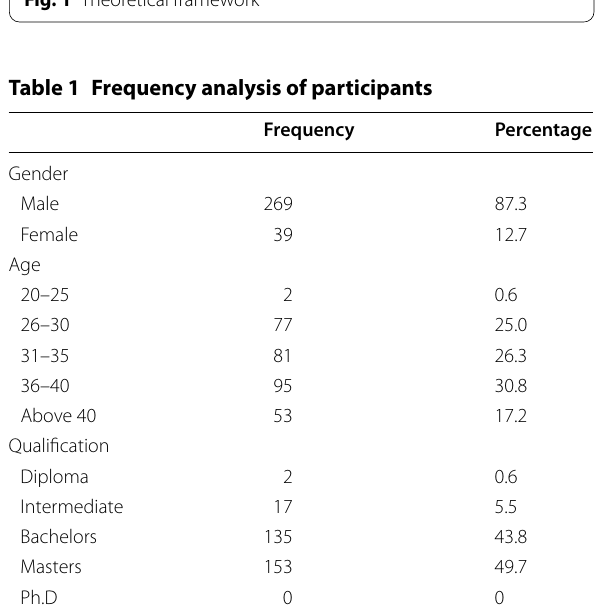
Fig. 1 Theoretical framework